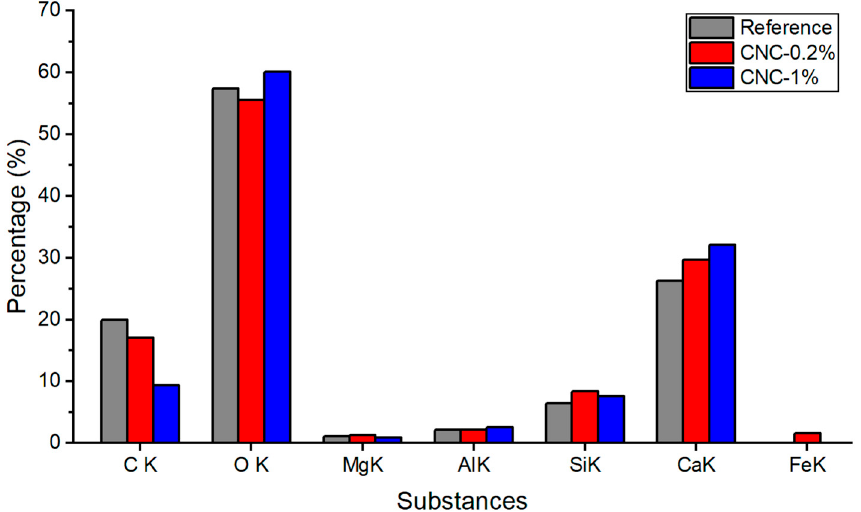
Figure 11. Energy dispersive X-ray spectroscopy (EDX) observations.